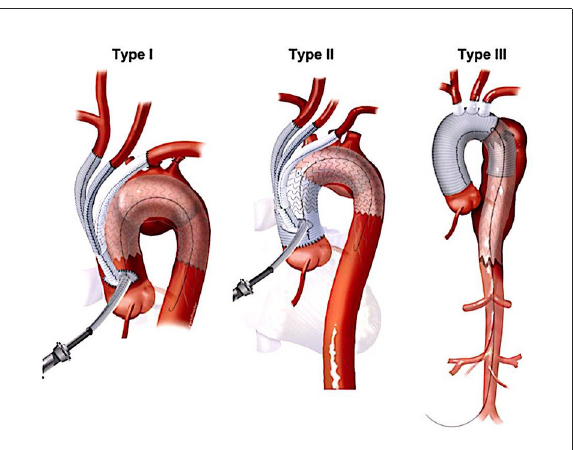
FIGURE2 Major types of hybrid arch repair (22). HAR, hybrid arch